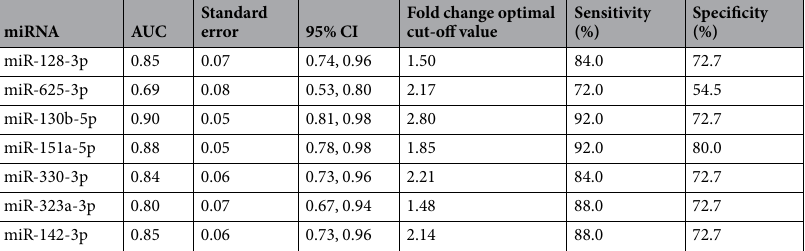
Table 2. Area under ROC curves for FRDA diagnosis.